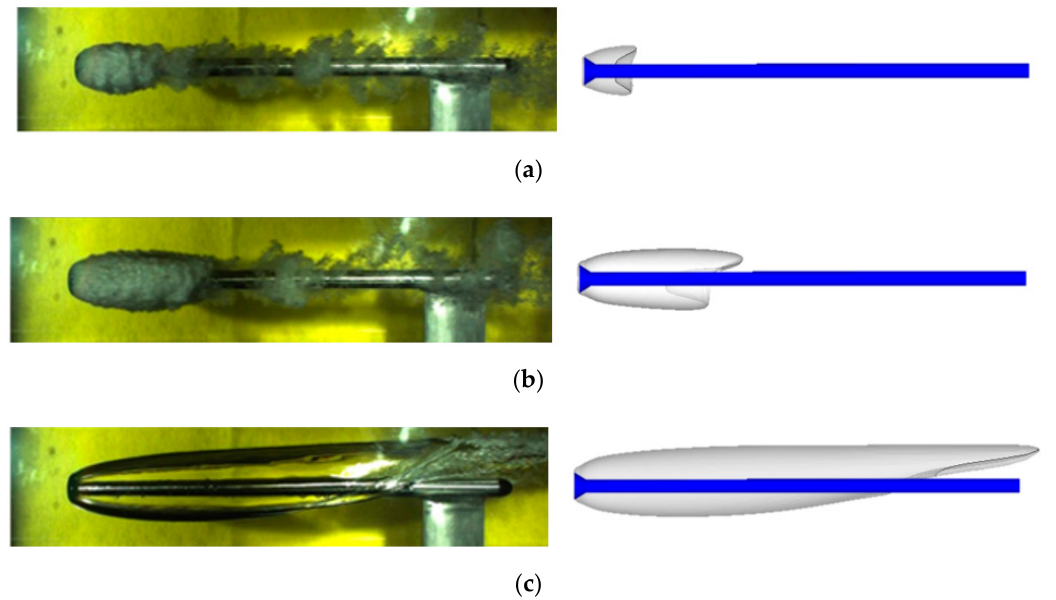
Figure 7. Cavitation formation at various ventilated rate coefficients. Figure 8. Cavitation formation at various ventilated rate coefficients (Fn = 10.8, Cq = 0.20). In this study, computational analysis was performed not only of the cavity shape, but also of the drag force in the injection cavity. The following Figure 9 models for drag analysis. The shapes of the cavitator, body, and ventilated areas are modeled with reference to the shape of the test [13]. Figure 10 is the result of computational analysis of the drag coefficient value according to the change in the injection cavitation number. The drag coefficient is given by